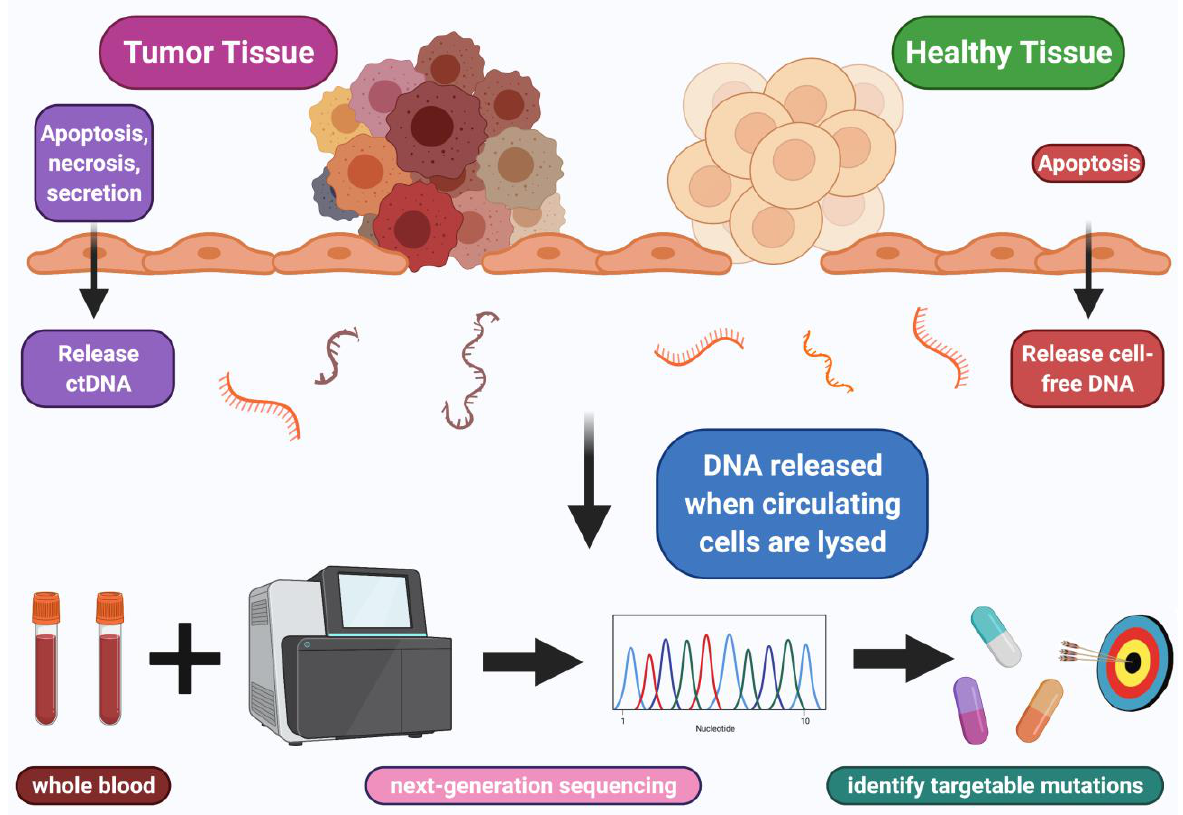
Figure 1. ctDNA employed to identify targetable mutations. Blood sample collected and next-generation sequencing performed on shed ctDNA from tumor, which can identify genomic alterations, some of which may be pharmacologically tractable.